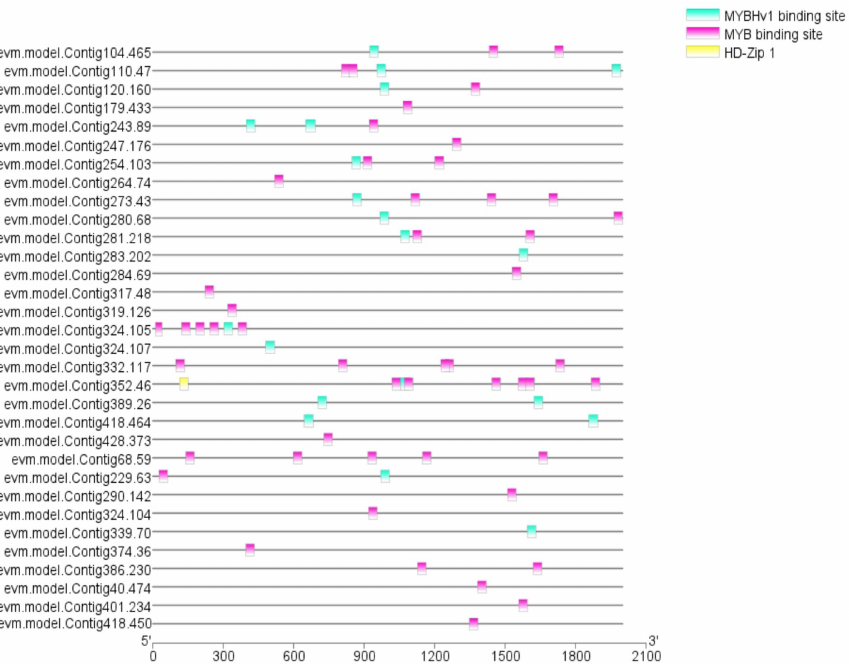
Figure 7. Promoter element analysis of 32 potential structural